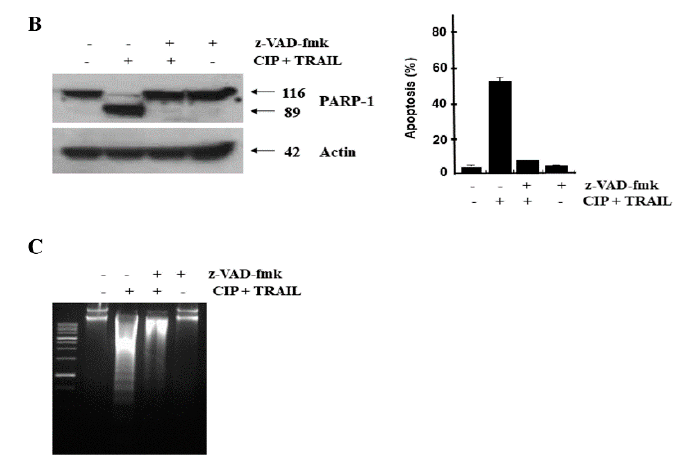
Figure 2. CIP treatment-induced caspase activation in A549 cells. ( A ) The protein expression of caspase-3, caspase-8, caspase-9, caspase-7, and PARP after treatment with different doses of CIP+TRAIL for 24 h. The total cells were collected and the lysates were subjected to western blotting with specific antibodies. Actin was used as a loading control. The proteolytic cleavages in PARP, cas-3, cas-8, cas-7, and cas-9 are indicated by arrows. ( B ) A549 cells were incubated with 50 µ M z-VAD-fmk for 1 h before treatment with CIP + TRAIL. Equal amounts of cell lysates (40 µ g) were electrophoresed and analyzed for PARP-1 by western blotting. The proteolytic cleavage of PARP is indicated by an arrow. ( C ) For analyzing DNA fragmentation, fragmented DNA was separated by using 1.5% agarose gel.